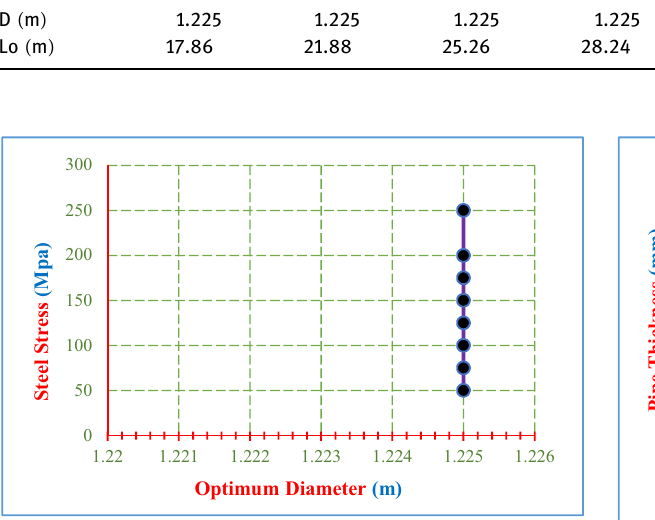
Figure 15: Pipe thickness vs optimum diameter.